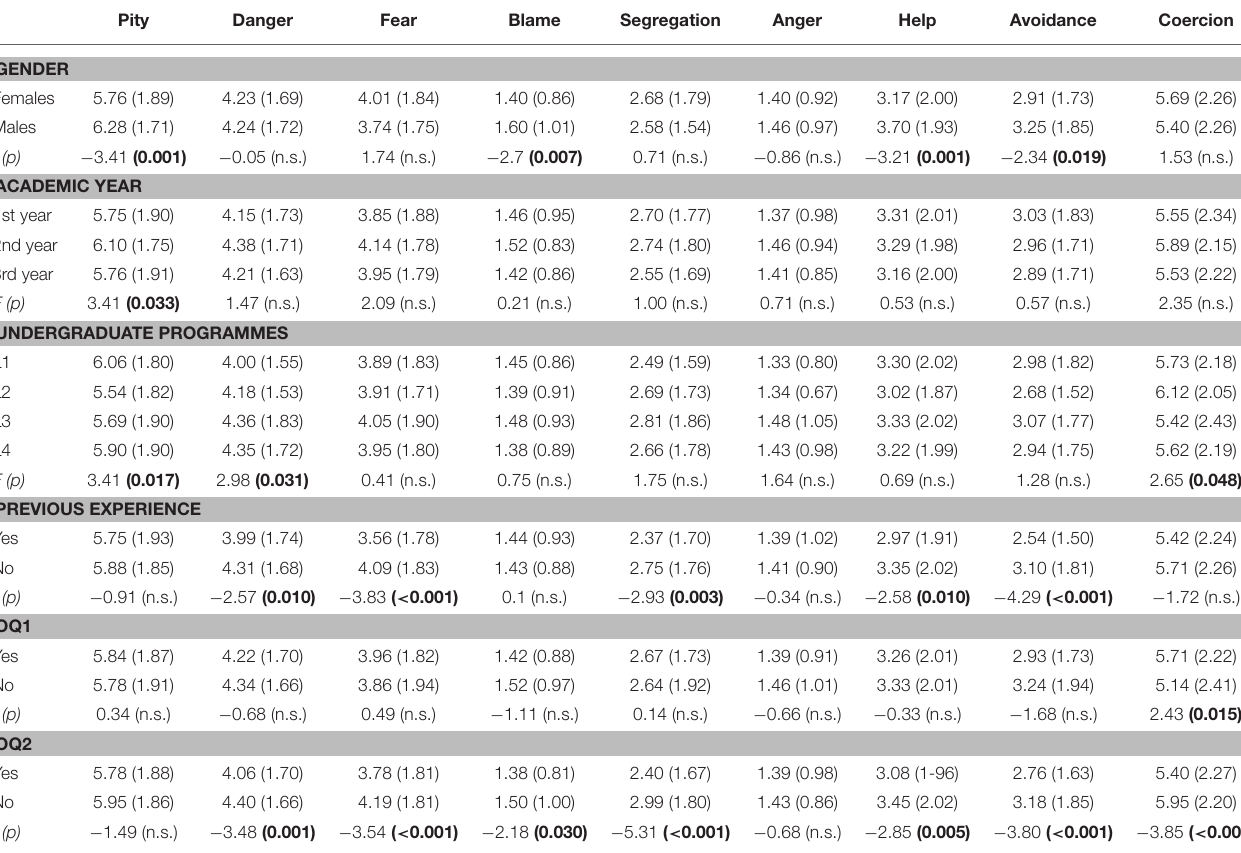
TABLE 2 | Effect of gender and academic variables on AQ-9 domains. Danger Fear Blame Segregation Anger Help Avoidance